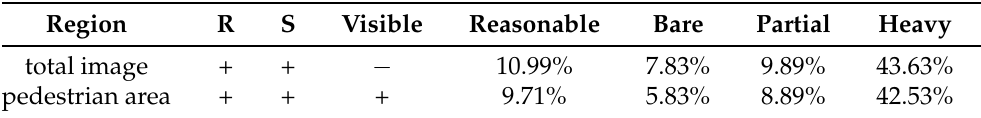
Table 1. Comparison of different strategies. R stands for resolution learning branch. S stands for segmentation learning branch.